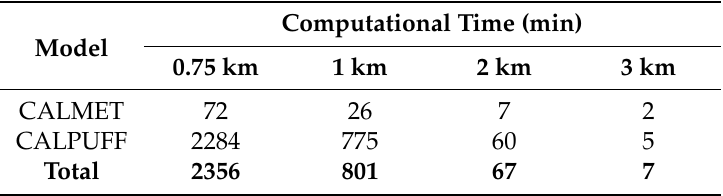
Table 1. Comparison of computational time used in CALMET (California Puff Mesoscale Diagnostic 3-Dimensional Meteorological Model)/CALPUFF (California Puff Mesoscale Dispersion Model) simulations for different computational grid resolutions.